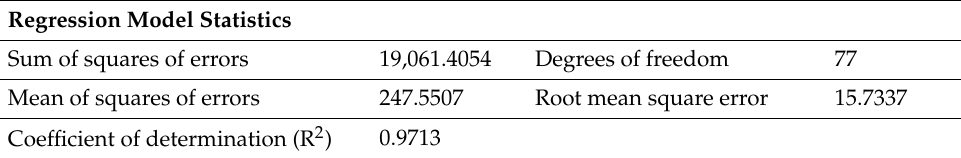
Table 3. Statistics on the fixed effects model evaluation. Regression Model